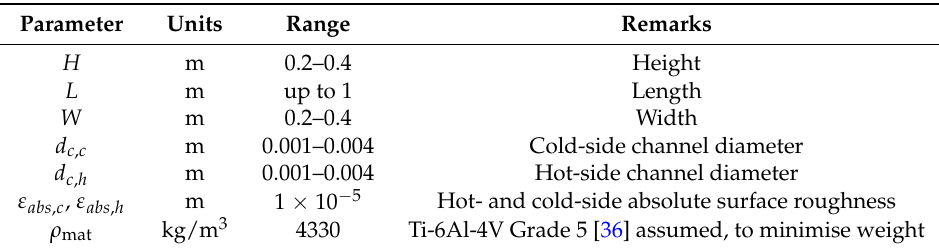
Table 5. Recuperator design